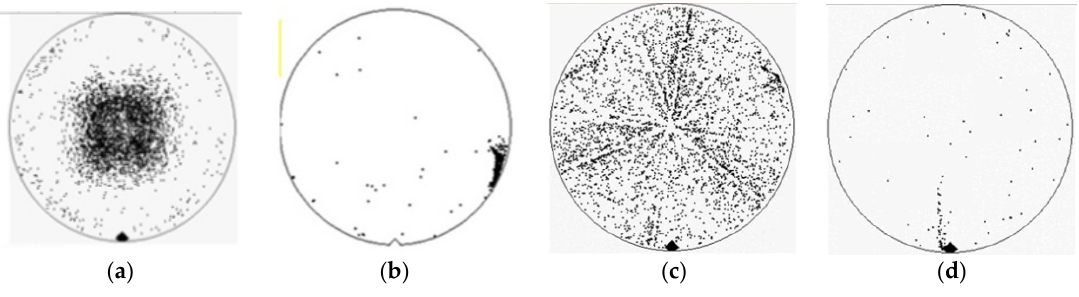
Figure 3. Defect types: ( a ) center, ( b ) local, ( c ) random, and ( d ) scrape .